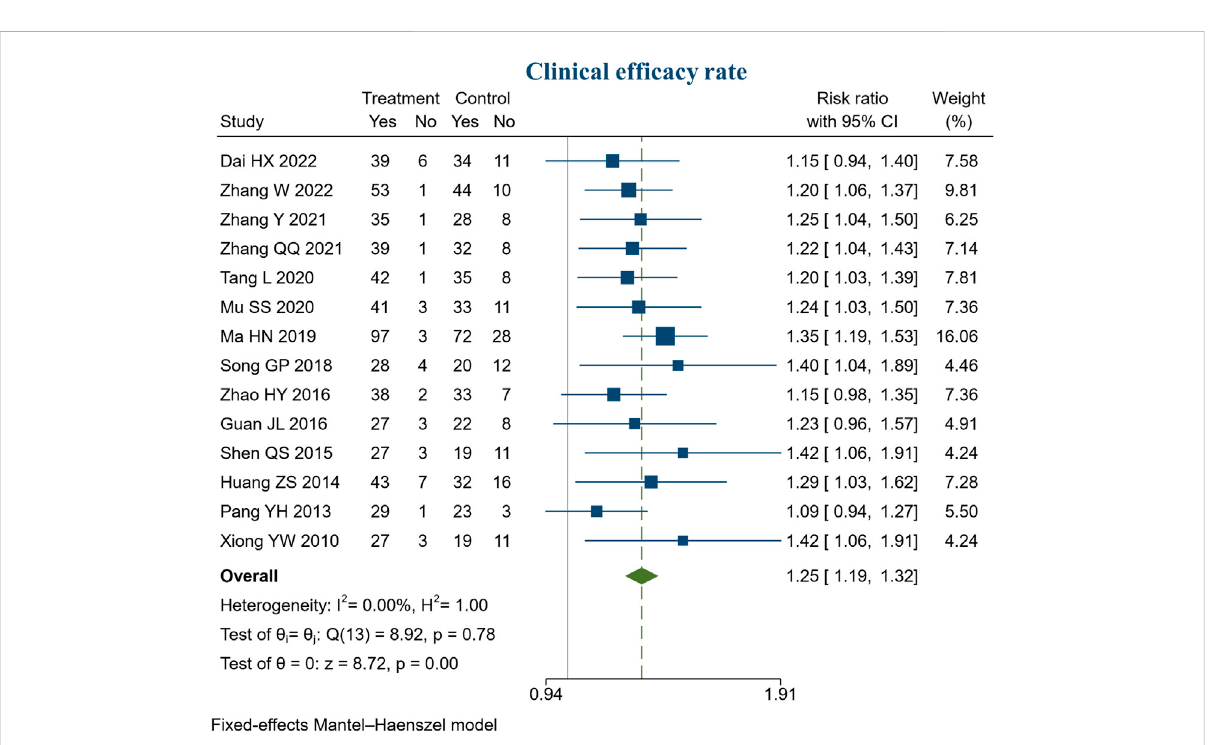
FIGURE 3 Forest plot of clinical ef fi cacy